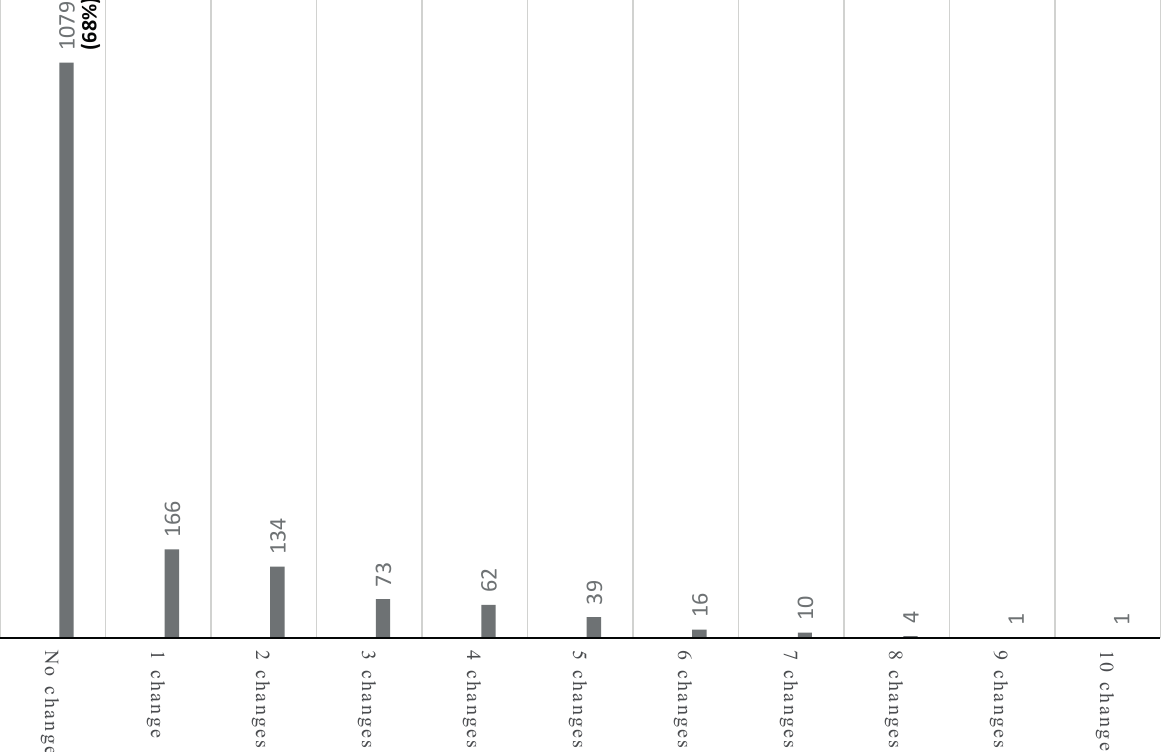
Figure 9. Farms per number of TF changes over the 2008-2019 period within the Italian FADN balanced sample.